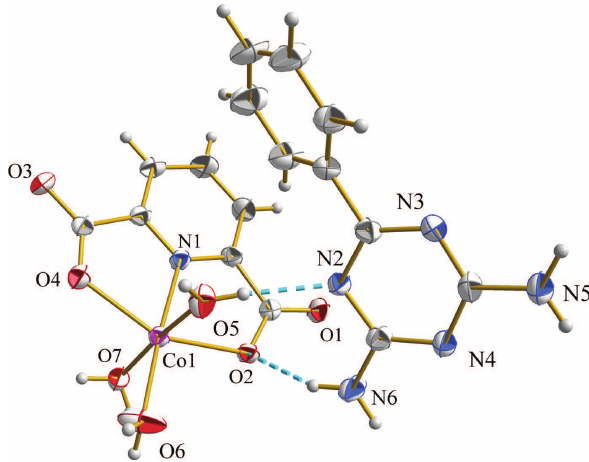
Table 1: Data collection and handling.